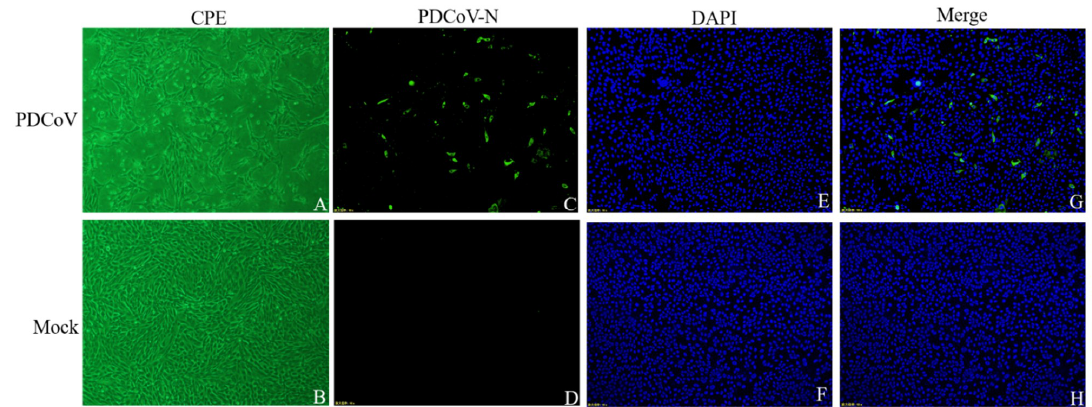
Figure 1. Isolation and identification of PDCoV CHN-SC2015 in LLC-PK cells by cytopathic effect (CPE) and immunofluorescence assay (IFA). The confluent LLC-PK cells were infected with PDCoV CHN-SC2015 and the CPE was recorded at 24 h post-infection. ( A ): Micro examination of the PDCoV-infected LLC-PK cells; ( B ): Micro examination of the mock-infected LLC-PK cells. ( C – H ): LLC-PK Cells were fixed and stained with rabbit anti-PDCoV N protein and FITC-goat anti-rabbit IgG at 24 h post-infection (green); nuclei were counterstained with DAPI (blue). Magnification = 10 × . Viral particles negatively stained with 2% sodium phosphotungstic acid were examined by EM.